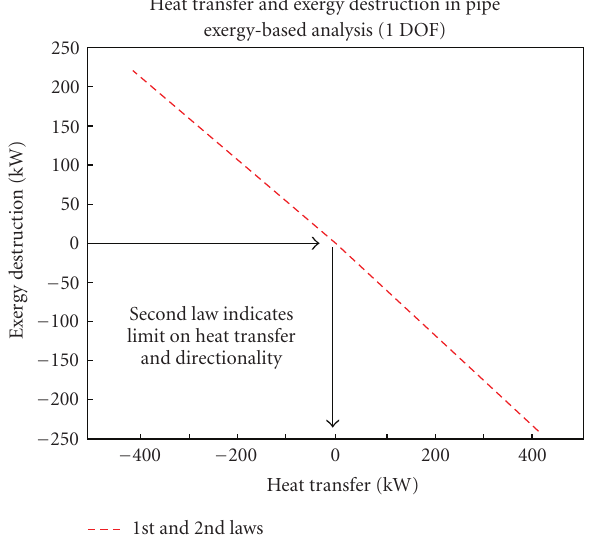
Figure 5: Relationship between heat transfer and exergy destruc- tion in System 2. Higher heat loss from System 2 results in greater exergy destruction. Note that only nonnegative exergy destruction is allowed and therefore heat gain in System 2 is not possible.